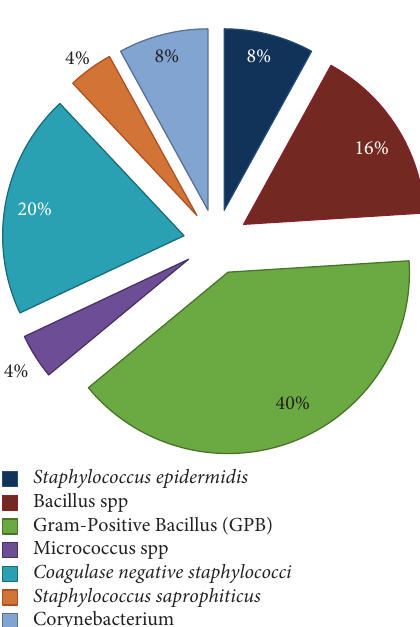
Figure 2: Distribution of isolated